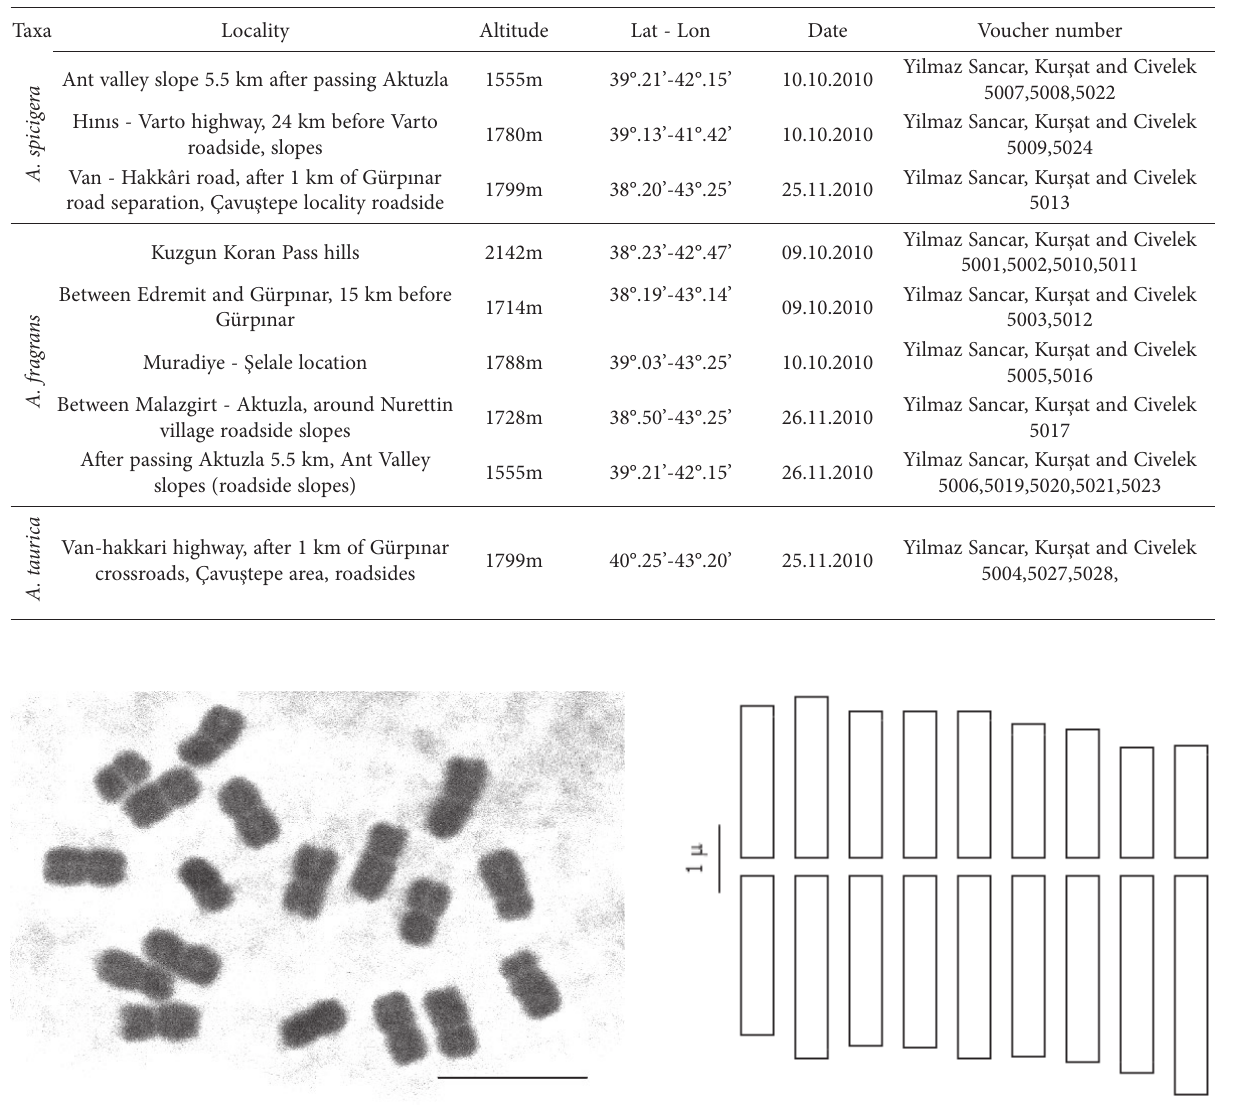
(Table 2). Idiograms of haploid chromosomes were drawn (Figure 2). The examined taxa and characteristics of somatic chromosomes are given in the results section.